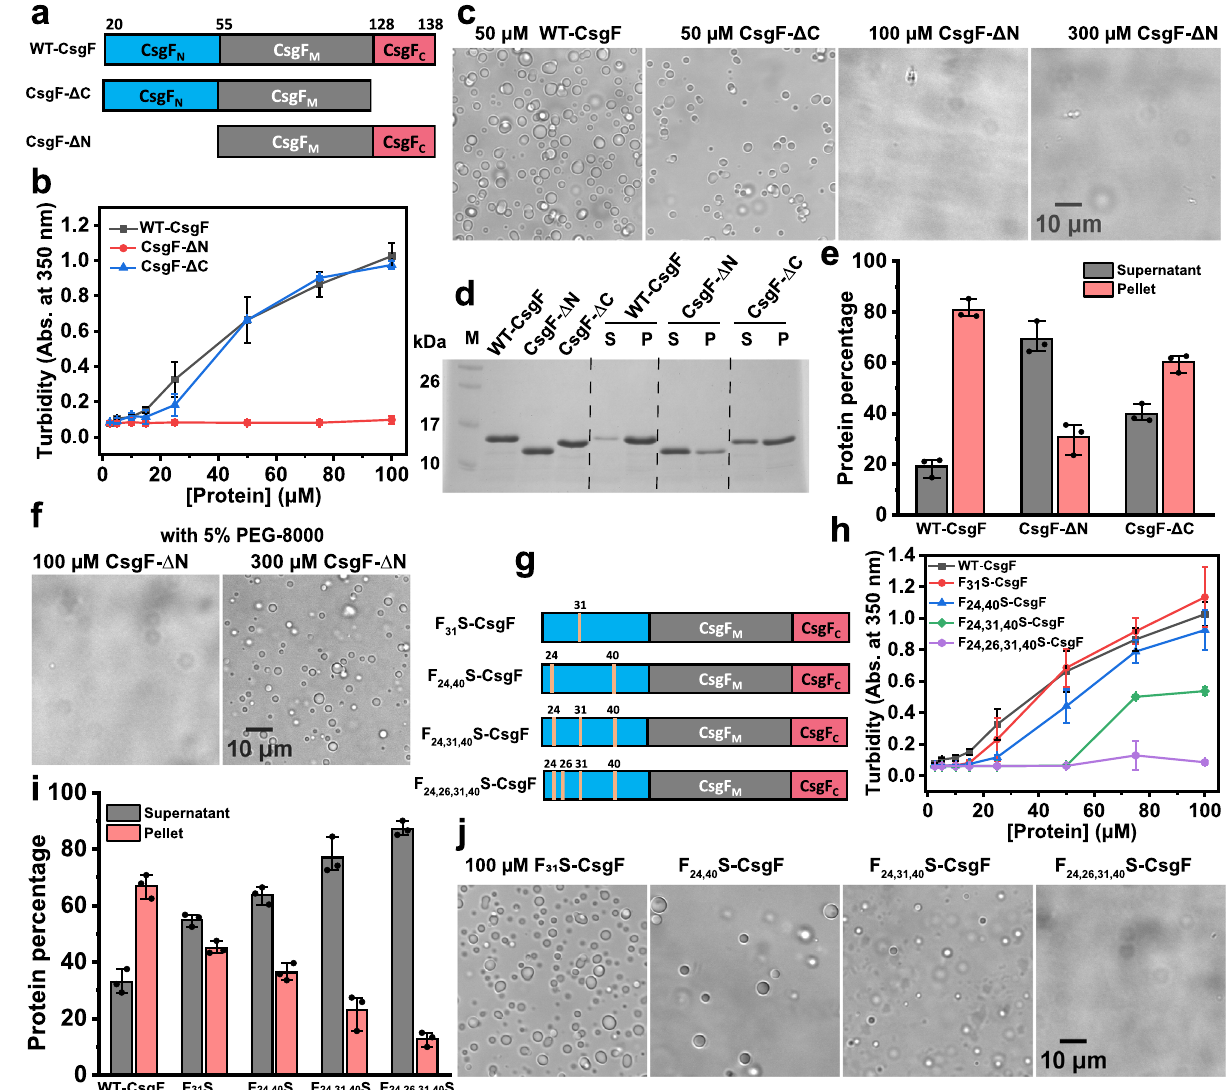
Fig.2|PhenylalanineresiduesintheN-terminusmodulatephaseseparationof CsgF. a Schematic representation of CsgF- Δ N and CsgF- Δ C used in the study. b TurbiditymeasurementsofWT-CsgF,CsgF- Δ N,andCsgF- Δ Cin25mMpotassium phosphate pH 7.5. The data represent mean±SD, n =3. c Images of WT-CsgF (50 µ M), CsgF- Δ C (50 µ M), and CsgF- Δ N (100 µ M and 300 µ M) in 25mM potassium phosphate pH 7.5. d Coomassie-stained SDS-PAGE on the supernatant and pellet samples of 50 µ M WT-CsgF, CsgF- Δ N, and CsgF- Δ C after centrifugation. M: Mole- cular weight markers, S: Supernatant, P: Pellet. e SDS-PAGE shown in ( d ) was quanti fi ed.Thedatarepresentmean±SD, n =3. f DICimagesof100 µ Mand300 µ M